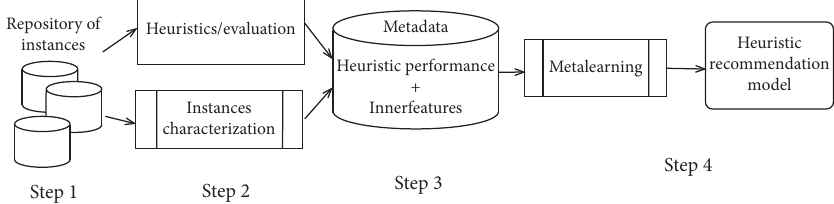
Figure 1: Metalearning to obtain metaknowledge for heuristic